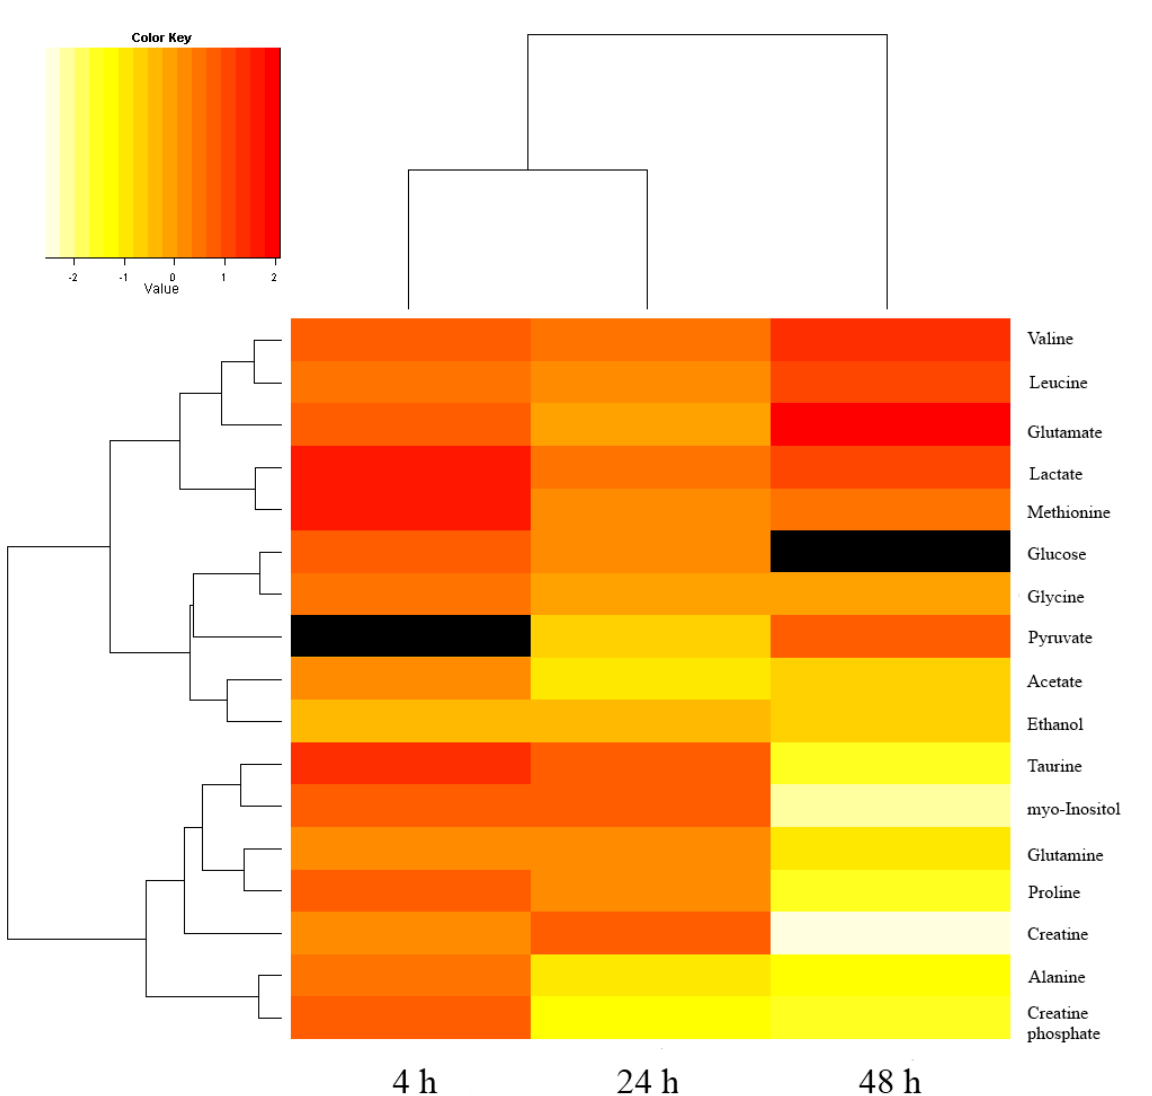
Figure 3. The quantified metabolites and fold changes in our study. The heatmap represents the log2-transformed fold changes for quantified metabolites with different treatments. The fold changes of pyruvate with 4 h treatment and glucose with 48 h treatment is not available, due to low concentrations (in black). n = 3 for each group at each time